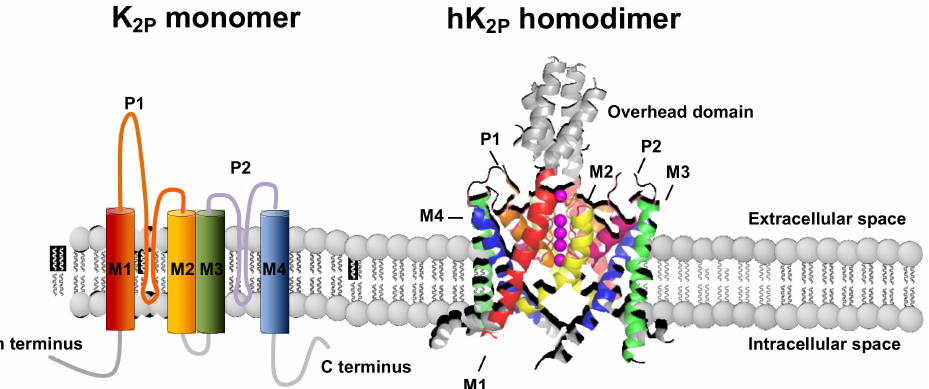
Figure 1. Membrane topology and structure of K 2P channels. K 2P channel monomers ( left ), consist- ing of 4 transmembrane domains (M1–4) and 2 pore forming loops (P1–2) assemble as homo- or heterodimers. ( right ).